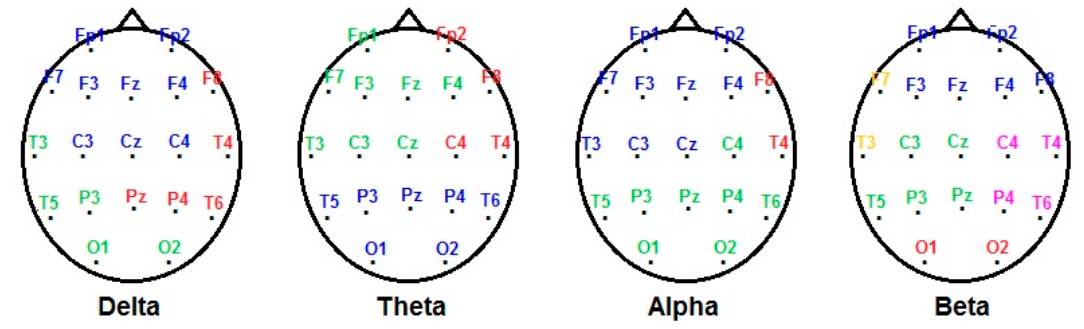
Figure 2. Topography of the factors resulting from the factor analysis of the z value of the electroencephalography (EEG) absolute power for each frequency band (delta, theta, alpha and beta). Factor 1 is represented in blue, factor 2 in green, factor 3 in red, factor 4 in pink, and factor 5 in yellow.